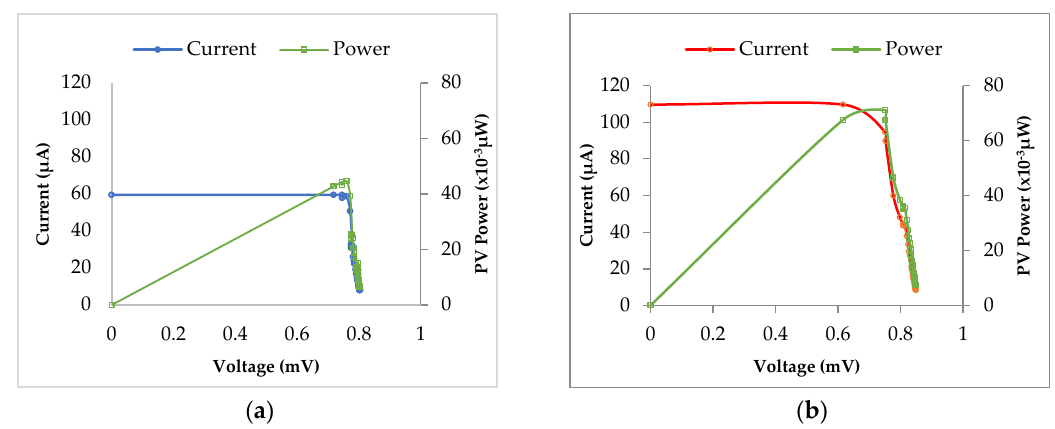
Figure 11. Characteristics of power-voltage (P-V) and current-voltage (I-V) in PV; ( a ) transmitted HM, ( b ) reflected